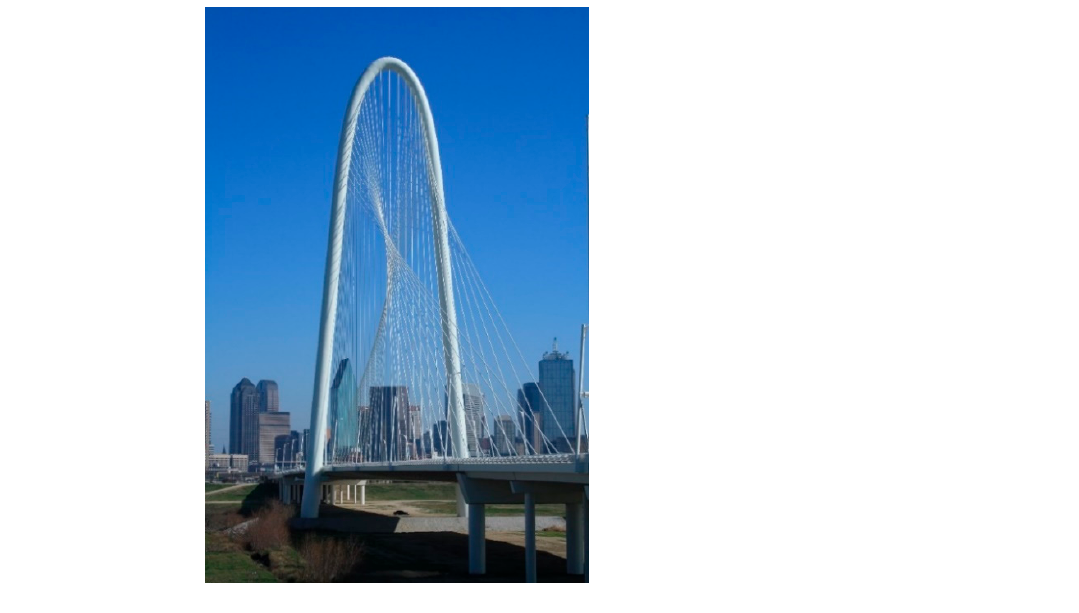
Figure 5. Margaret Hunt Hill Bridge (12g) (photo: DMHinIrving, Wikimedia Commons).